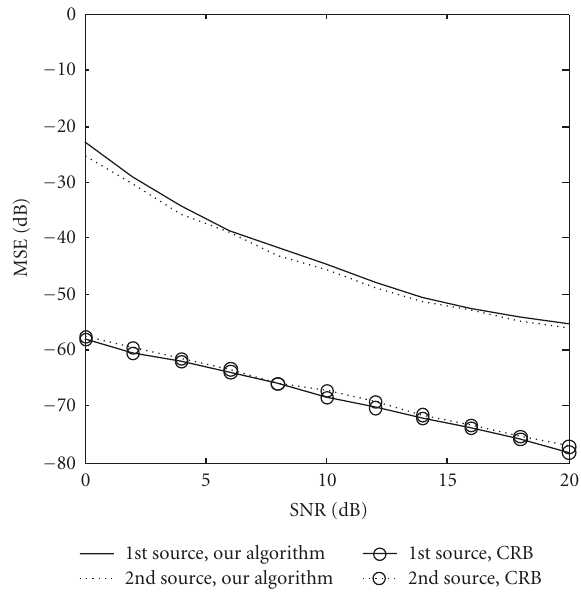
Figure 2: Estimation MSE of the frequencies versus input